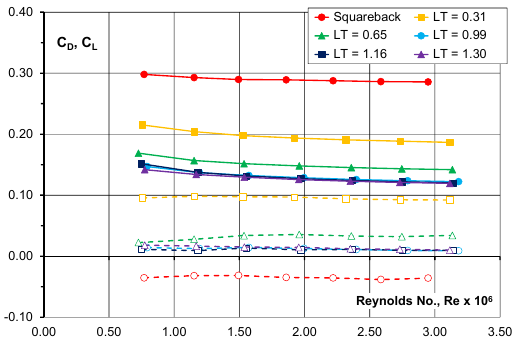
Figure 4. Effect of Reynolds number on drag and lift coefficients at 0° yaw. Drag coefficient, (solid symbols), lift coefficient, (open symbols).